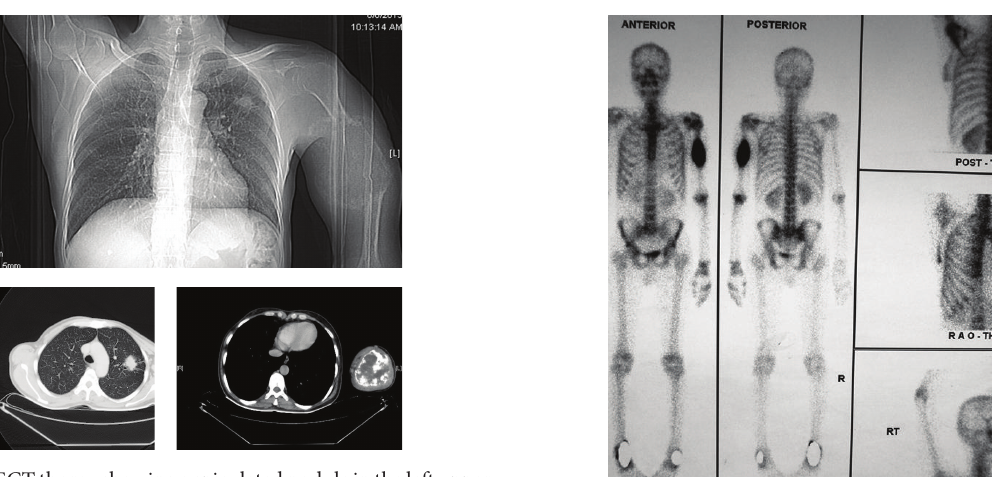
Figure3:CECTthoraxshowingaspiculatednoduleintheleftupper lobe with osteolytic lesion in middle of the humerus on the left side.